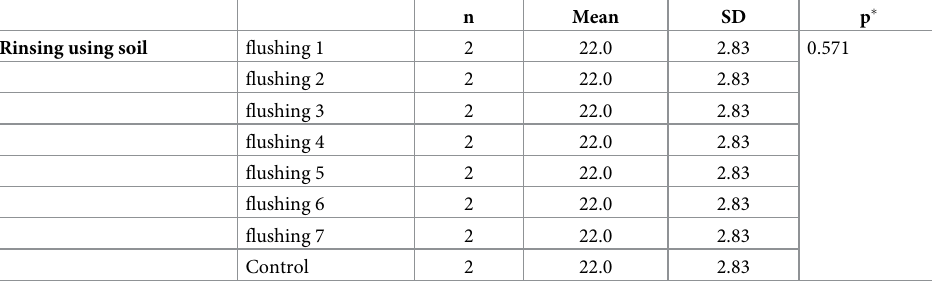
Table 1. Baseline of bacterial count data (CFU/ml 2 ) on infusion bottles.